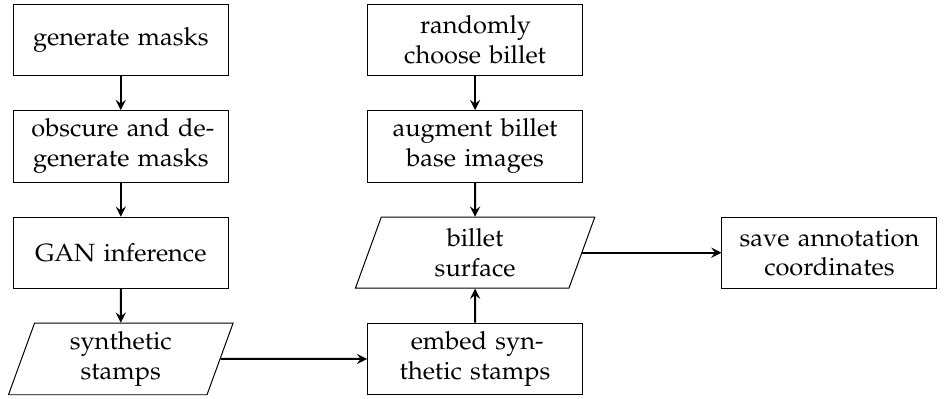
Figure 5. Workflow of stamp